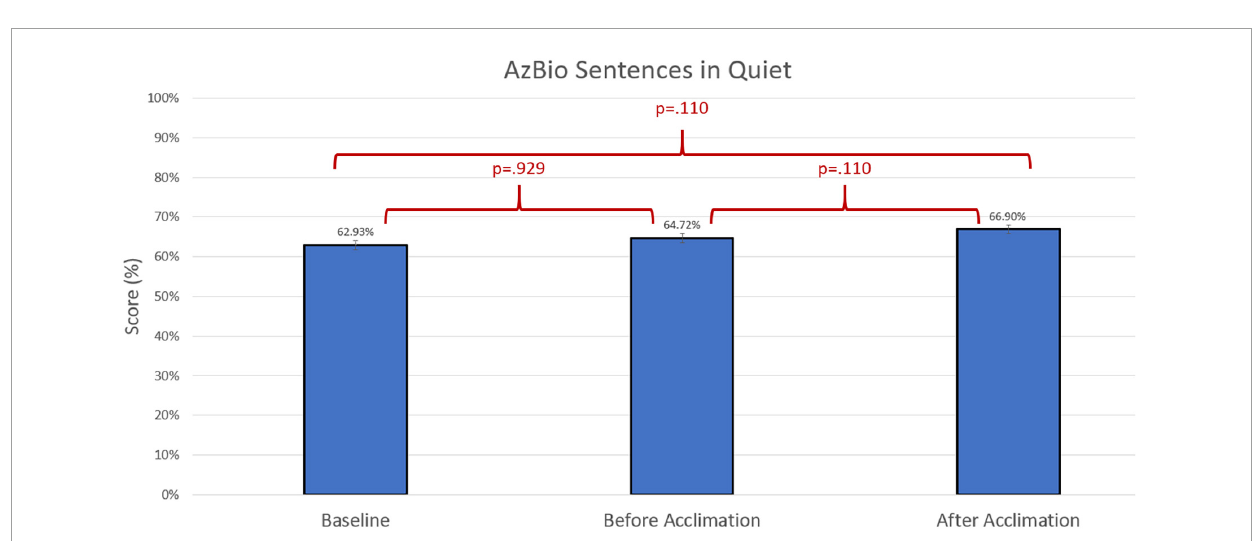
FIGURE4 Comparison of average group performance on AzBio Sentences in quiet using the baseline and experimental program before and after the acclimation